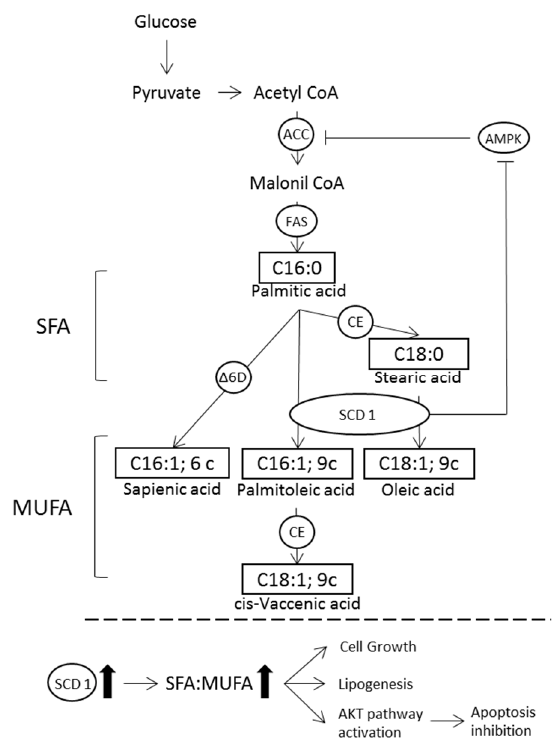
Figure 1. Mechanism for the control of de novo synthesis and lipid metabolism in cancer cells by SCD1. A high activity of SCD1 promotes the conversion of SFA to MUFA and keeps lipogenesis active by modulating potential mechanisms: (i) Maintaining ACC in an activated state by reducing levels of SFA, which are allosteric inhibitors of ACC; (ii) inactivating the AMPK (5’ adenosin monophosphate-activated protein kinase), which promotes the inactivation of ACC. SCD1 also plays a key role in enhancing the mitogenic and tumorigenic capacity of cancer cells. ACC, acetyl CoA carboxylase; FAS, fatty acid synthase, CE, 2-carbon chain elongation; ∆ 6D, delta-6-desaturase; SCD1, stearoyl CoA desaturase-1; SFA, saturated fatty acid; MUFA, monounsaturated fatty acid